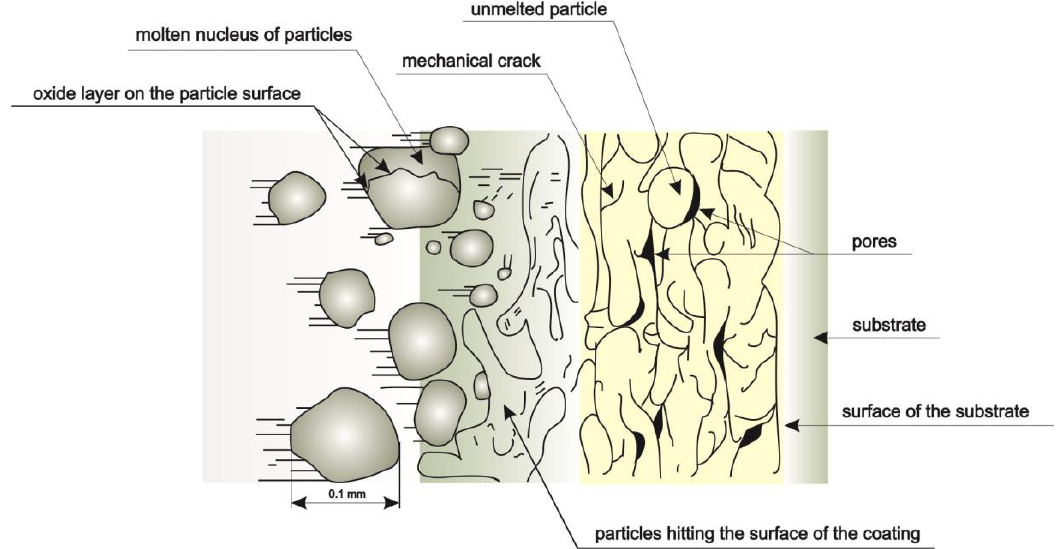
Figure 2. Scheme of the coating formation, adapted from [20].